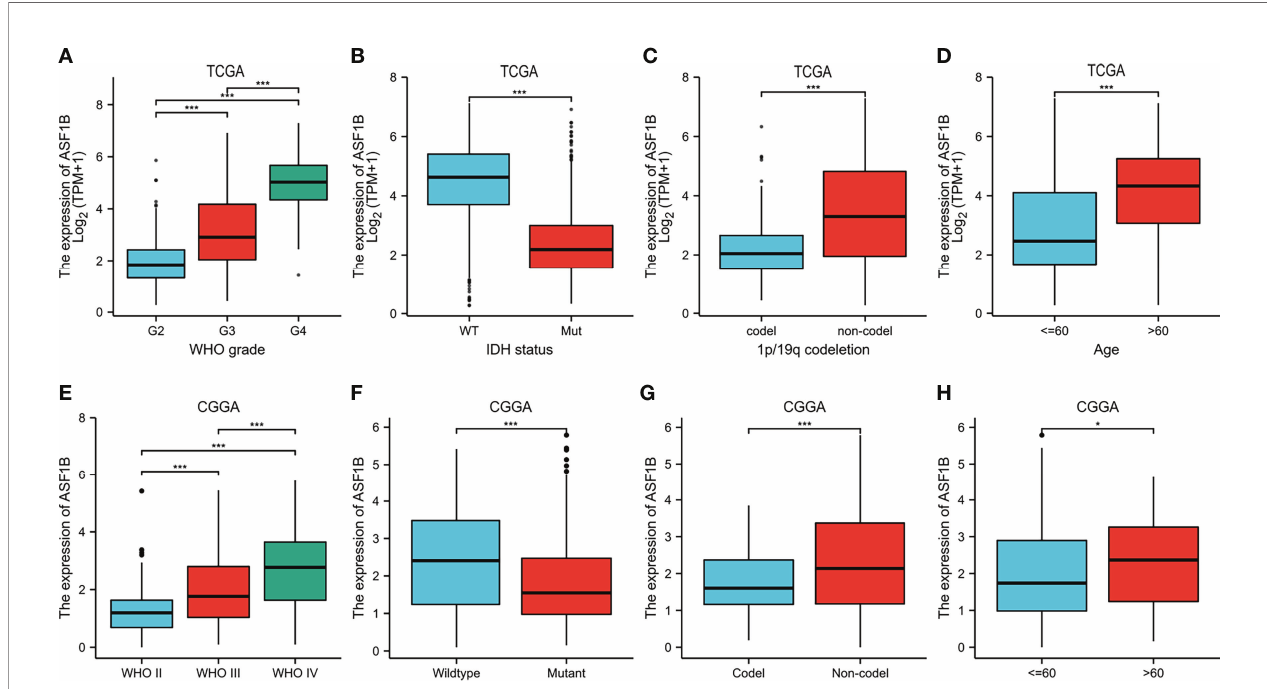
FIGURE 3 | Relationship between ASF1B expression and clinicopathological features. (A – D) The association of ASF1B expression with WHO grade (A) , IDH status (B) , 1p/19q codeletion (C) , and age (D) in gliomas from the TCGA database. (E, F) The association of ASF1B expression with WHO grade (E) , IDH status (F) , 1p/ 19q codeletion (G) , and age (H) in gliomas from the CGGA database. * p < 0.05, ** p < 0.01, *** p < 0.001.